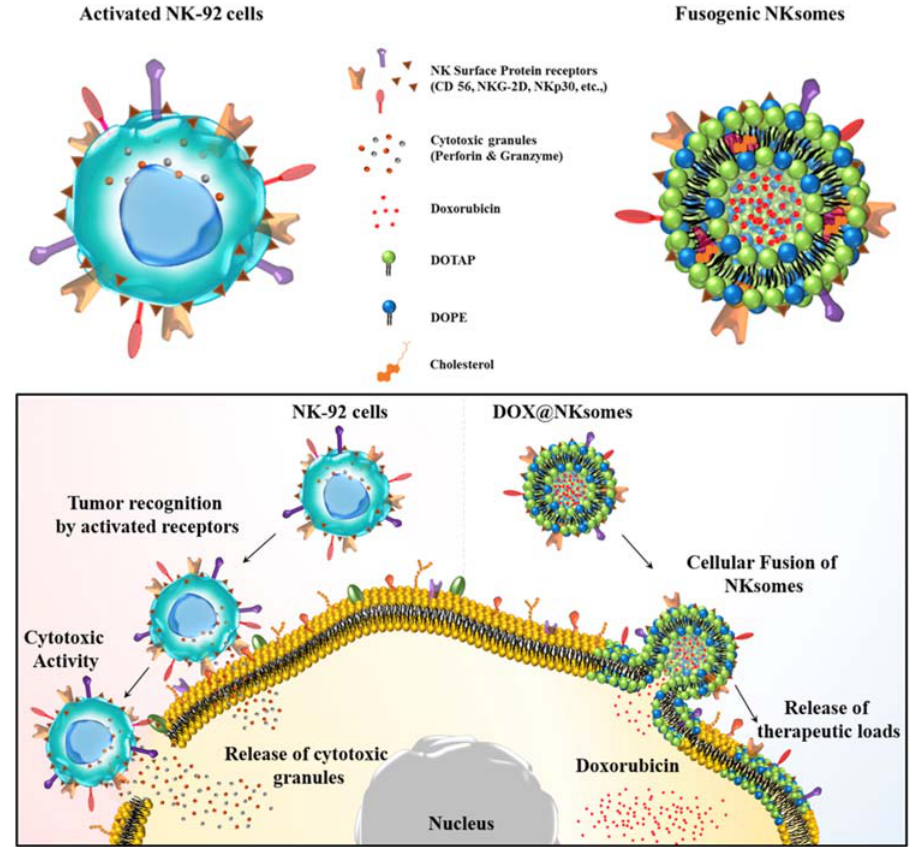
Figure 7. Schematic illustration of NK cells and NK cell membrane-derived fusogenic liposomes (NKsomes). Fusogenic liposomes recognize tumor cells and help release the therapeutic loads. Reproduced with permission from Ref [26]. Copyright © 2018 Elsevier Ltd. All rights reserved.